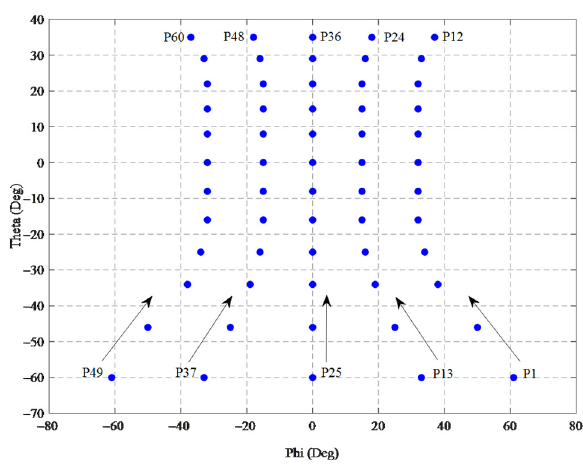
Figure 11. The 2D scheme of spatial scanning. Table 2. The frequency and input beam ports numbers of 60 patterns.